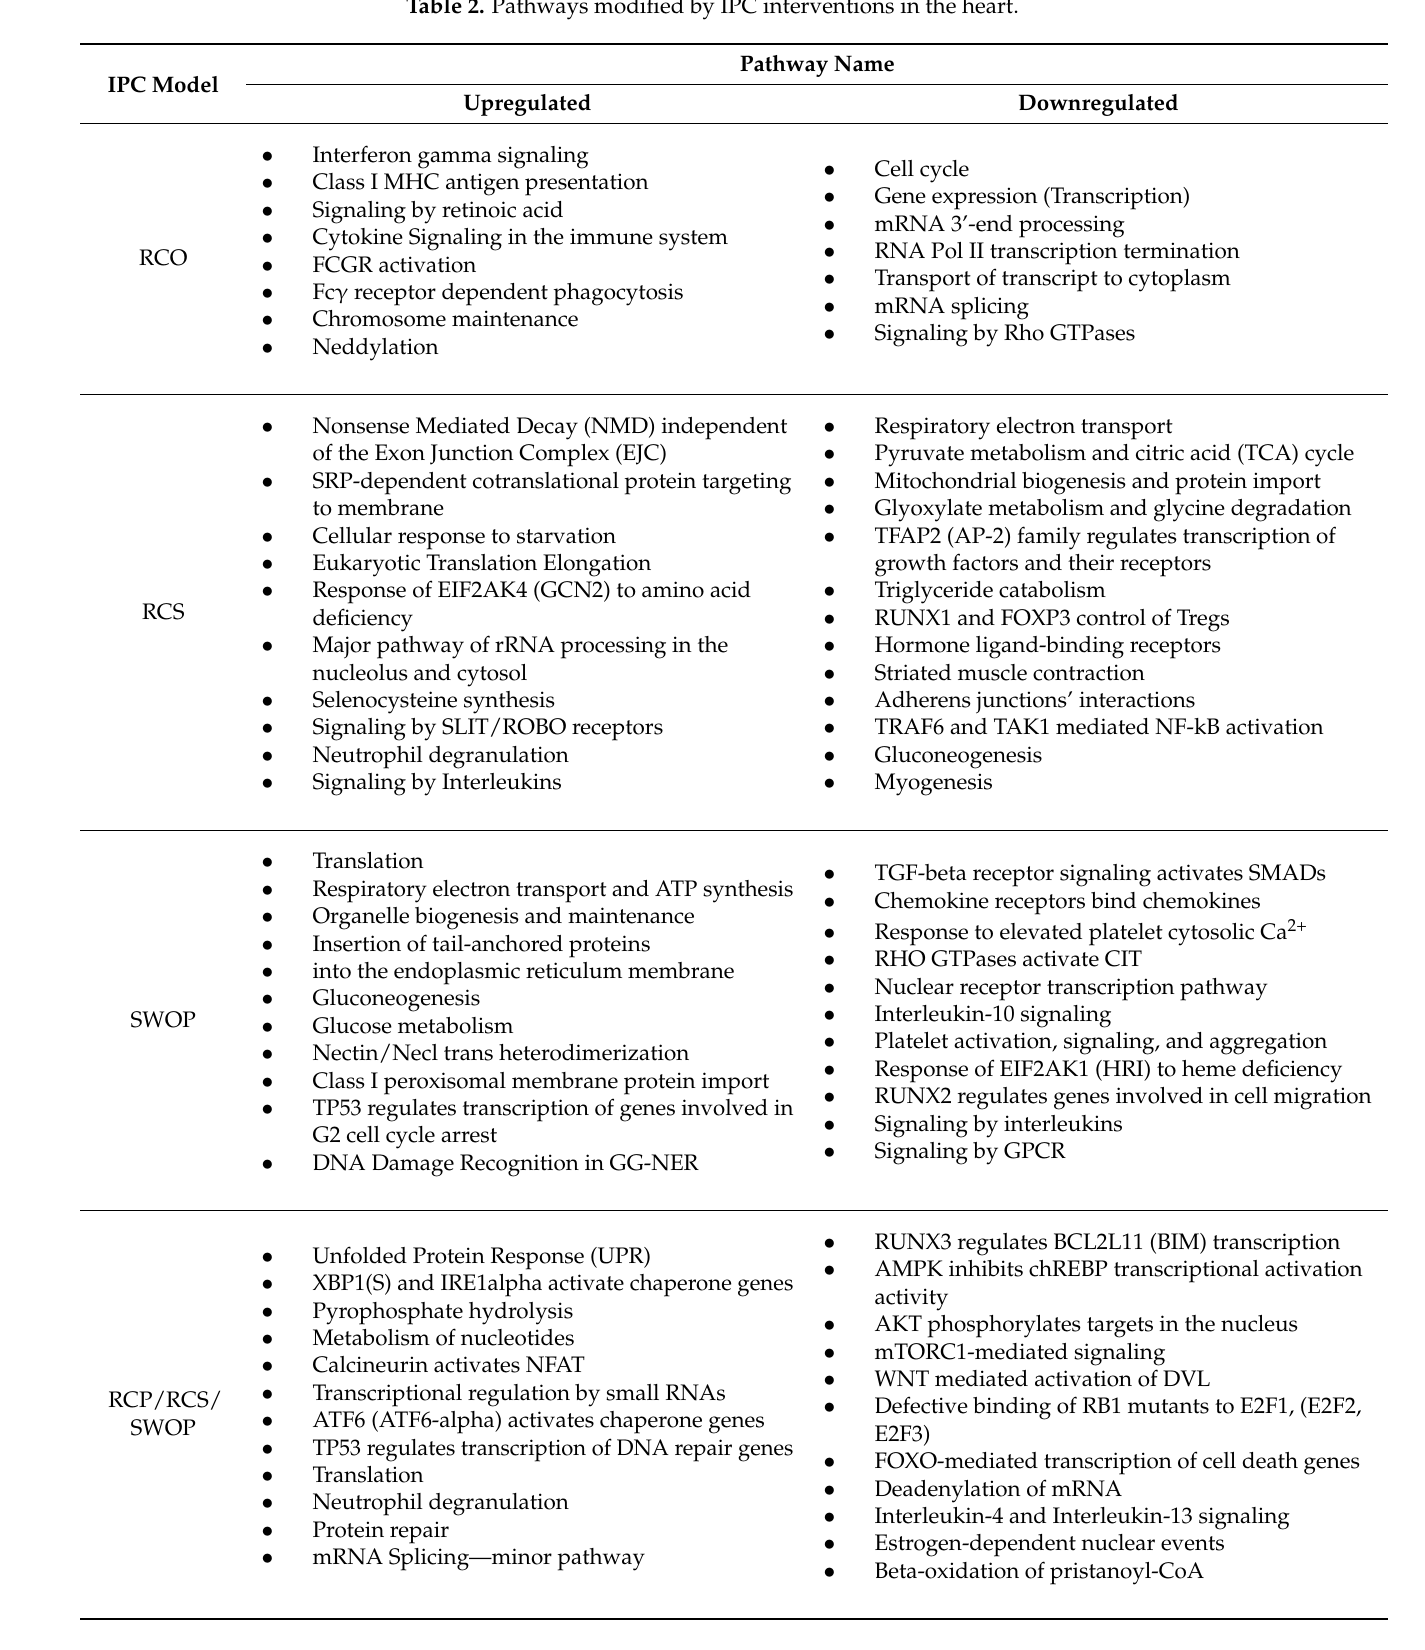
Table 2. Pathways modified by IPC interventions in the